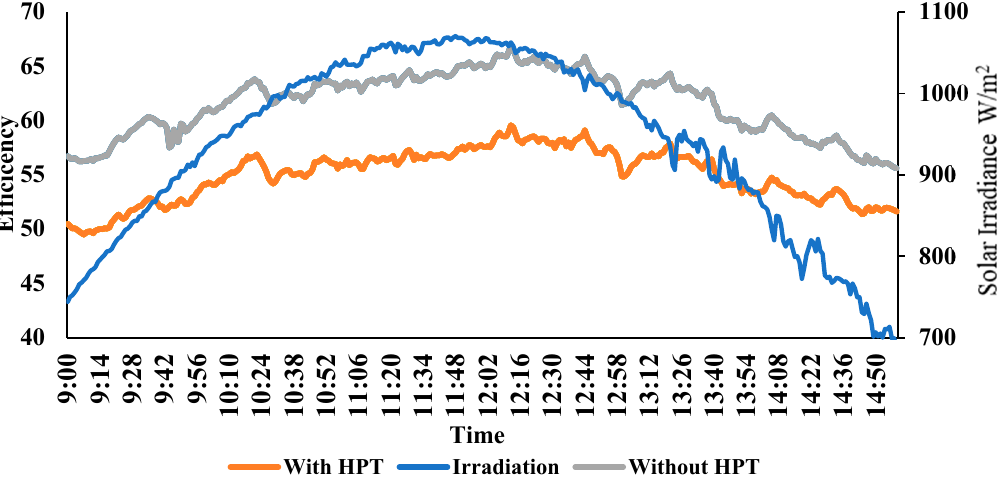
Figure 5. The temperature reference PV panel and the PV panel with 50 mL acetone.